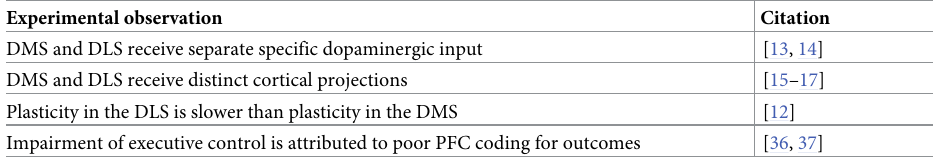
Table 1. Key additions that extend the model from prior